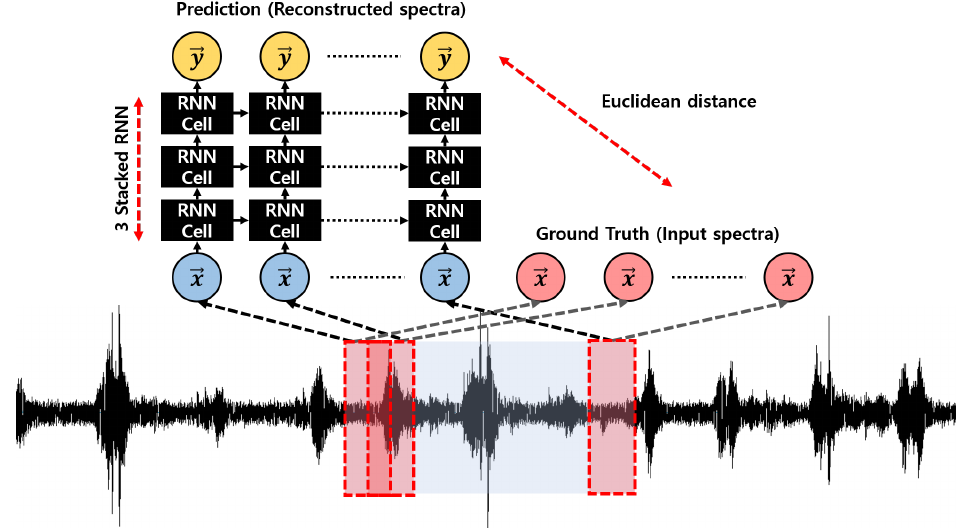
Figure 3. Structure of Fast Adaptive Recurrent Neural Network (RNN) Encoder–Decoder (FARED). The input is constructed by sequential spectrum (red box). Each spectrum has 50% of overlapping in the time domain. The output is a sequential reconstructed spectrum from input sequences. The Euclidean distance between prediction and ground truth is used for training and anomaly